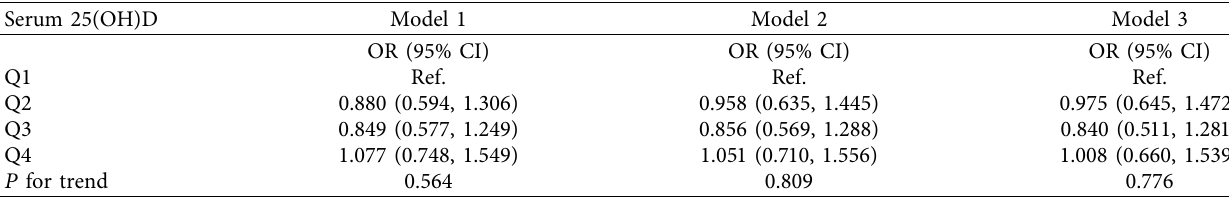
Table 3: Adjusted ORs for associations between serum 25(OH)D and the risk of